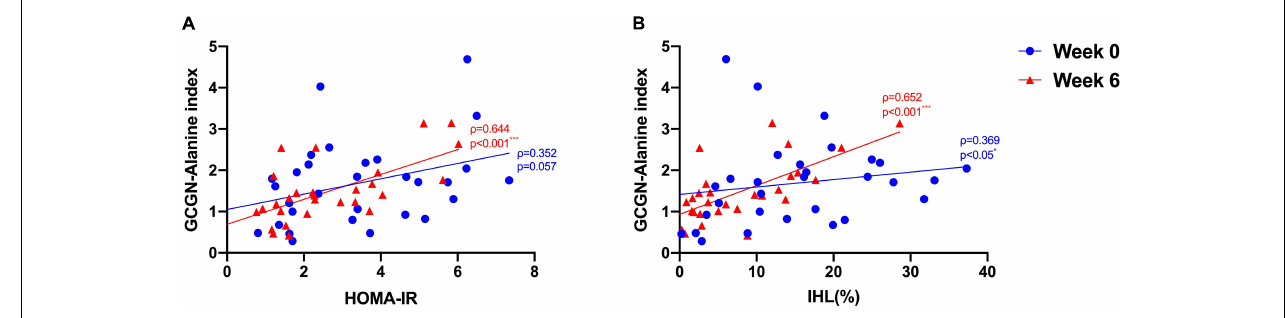
FIGURE 2 | Correlations between (A) GCGN–alanine index and HOMA-IR; (B) GCGN–alanine index and IHL (%) before (Week 0, blue) and after the intervention in the entire study group (Week 6, red). * p < 0.05; *** p < 0.001. TABLE 2 | Parameters at baseline (Week 0) and after HPD intervention (Week 6) of study participants with lower (below median) and higher (above median) reduction of intrahepatic lipid content (IHL). Parameter Lower liver fat reduction ( n = 16) Higher liver fat reduction ( n = 15) p week 6 vs below median above median week